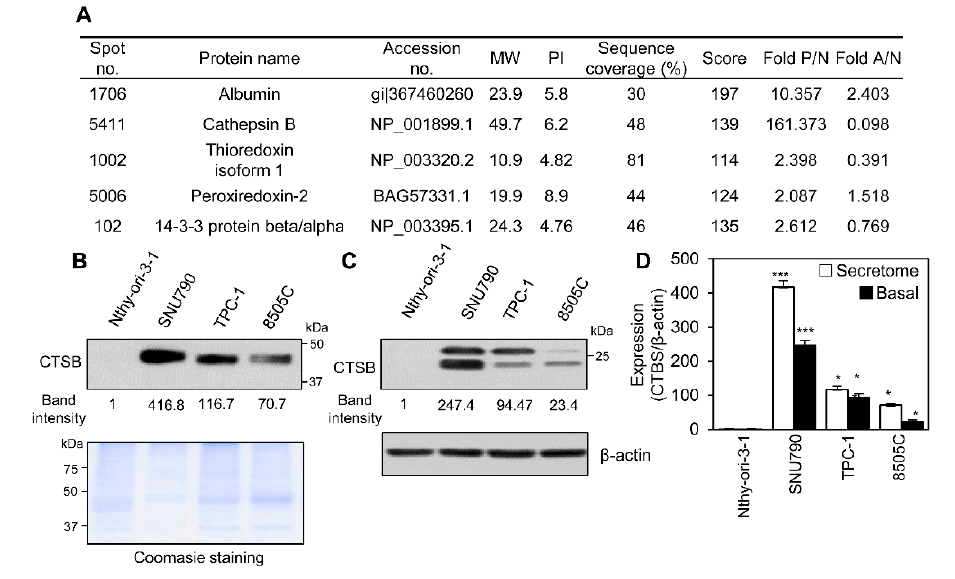
Figure 1. Higher expression of cathepsin B (CTSB) in PTC cell lines. ( A ) The identified list of DEPs in the secretome of thyroid epithelial cell (N), PTC cell (P), and anaplastic thyroid cancer cell (A) using proteomic analysis. ( B ) Western blot of secreted CTSB levels in conditioned media of cultured thyroid cancer cell lines (top). Proteins of the secretome were stained with CBB-R250 on the SDS–PAGE gel (bottom). ( C ) Analysis of basal CTSB levels in Nthy-ori-3-1, SNU790, TPC-1, and 8505C cells using Western blotting. ( D ) Analysis of relative CTSB expression in the secretome and its basal levels in thyroid cancer cell lines. The band intensity of CTSB expression was measured with ImageJ software and was normalized to β -actin or Coomassie staining. The relative intensity of CTSB in the Nthy-ori-3-1 was set to 1. Band intensity of CTSB level in SNU790, TPC-1, and 8505C was reported as fold-change compared to Nthy-ori-3-1. * p < 0.05, *** p < 0.001.